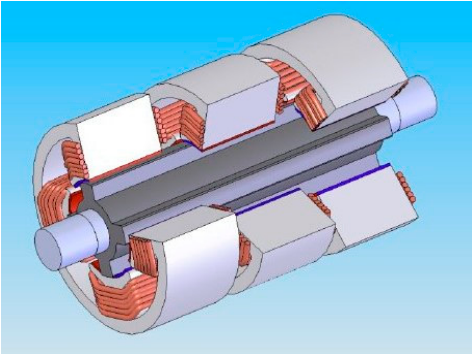
Figure 3. The design of three-phase high-speed FRM.